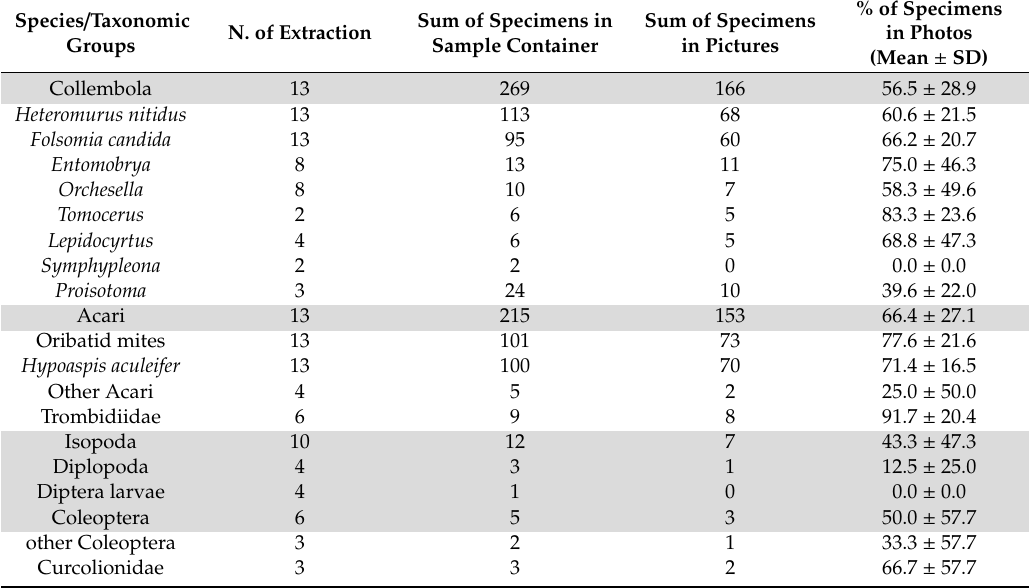
Table 2. Results of the semi-natural extraction test. Microarthropods were placed in defaunated soil and were extracted in Berlese funnels equipped with the probes. We recorded the number of specimens in the sample container of the probe and the number of specimens recognized in the photos. The ratio of these two values is shown in the last column (% of specimens in photos), which indicates the accuracy of the